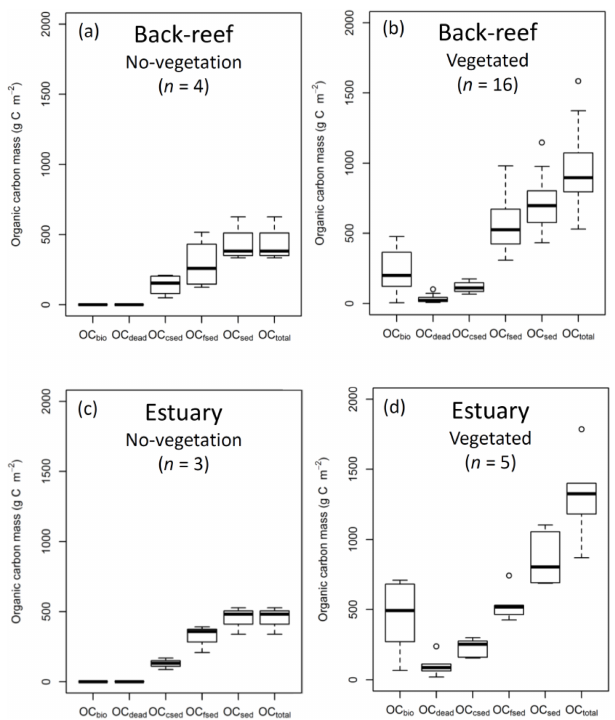
Figure 4. OC mass (OC bio , OC dead , OC csed , OC fsed , OC sed , and OC total ) at (a) no-vegetation (bare and unvegetated) points at the back-reef site, (b) vegetated points at the back-reef site, (c) no- vegetation points at the estuarine site, and (d) vegetated points at the estuarine site. Boxes show the 25 and 75% quantiles; horizontal bands inside the boxes are median values; whiskers show maximum and minimum values; and the open circles are